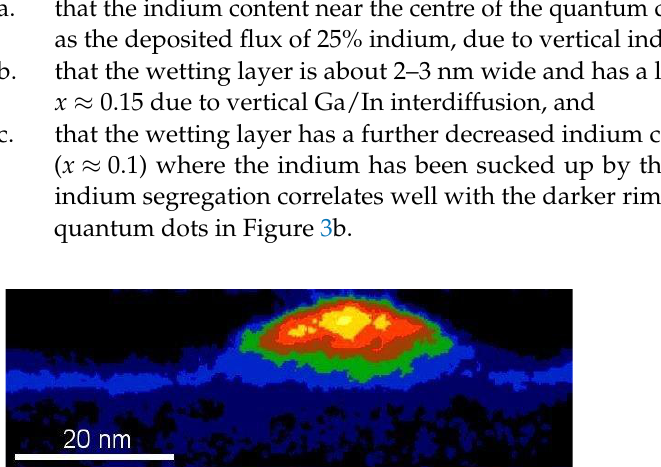
Figure 3. AFM topography maps of 3 nm (about 2.6 pure InAs equivalent ML) In x Ga 1−x As layers with x = 0.24 ( a ) and x = 0.25 ( b ). Reproduced with permission from [11].